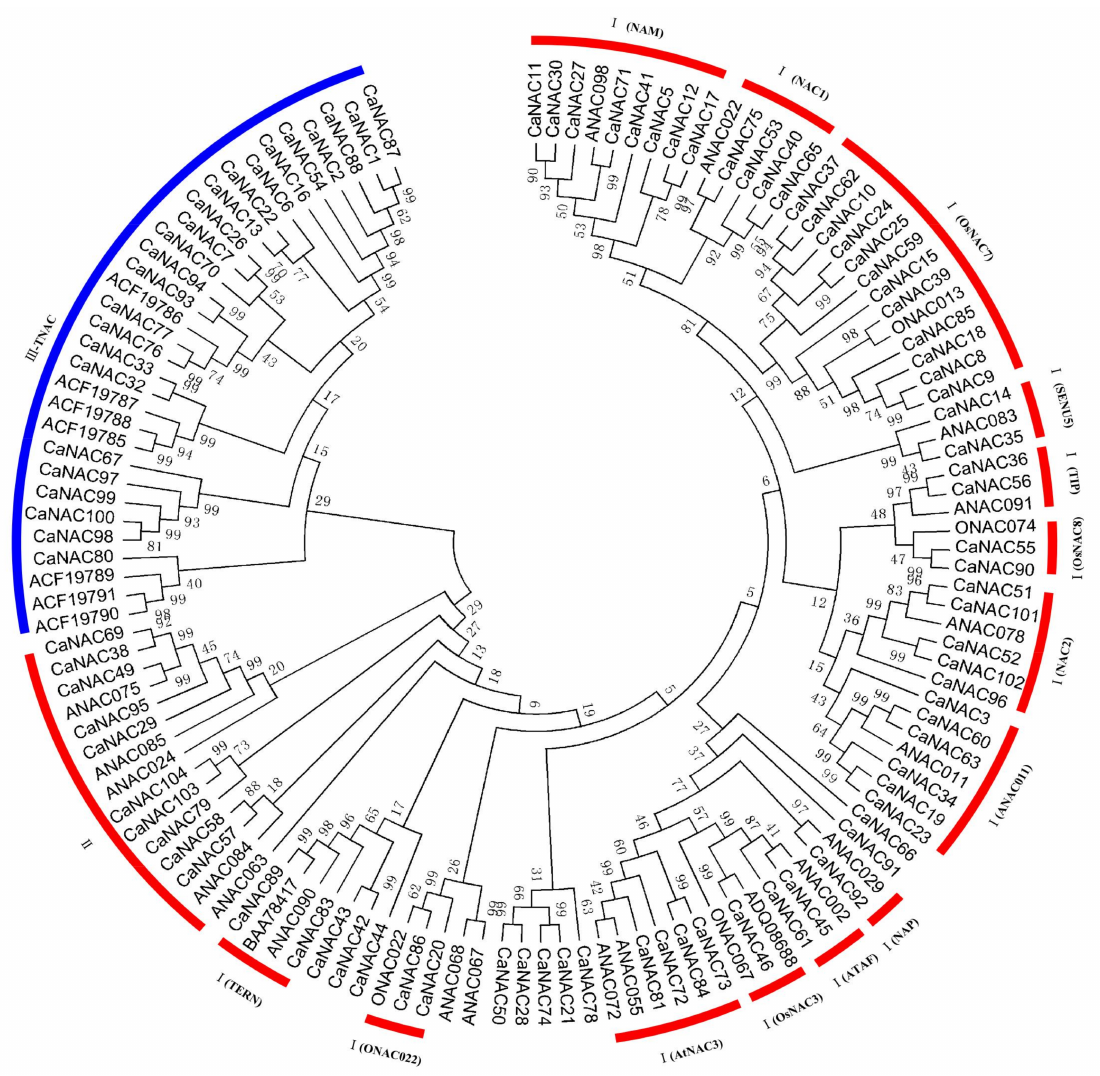
Figure 2. Unrooted phylogenetic tree representing the relationships among the NAC domains of pepper, potato, rice, and Arabidopsis . The amino acid sequences of all NAC domains were aligned with Clustal W (University College Dublin, Belfield, Dublin, Ireland), and the phylogenetics tree was constructed using the neighbor-joining method in MEGA 6.06 (Tokyo Metropolitan University, Hachioji, Tokyo, Japan). The red arcs indicate different groups or subgroups of NAC